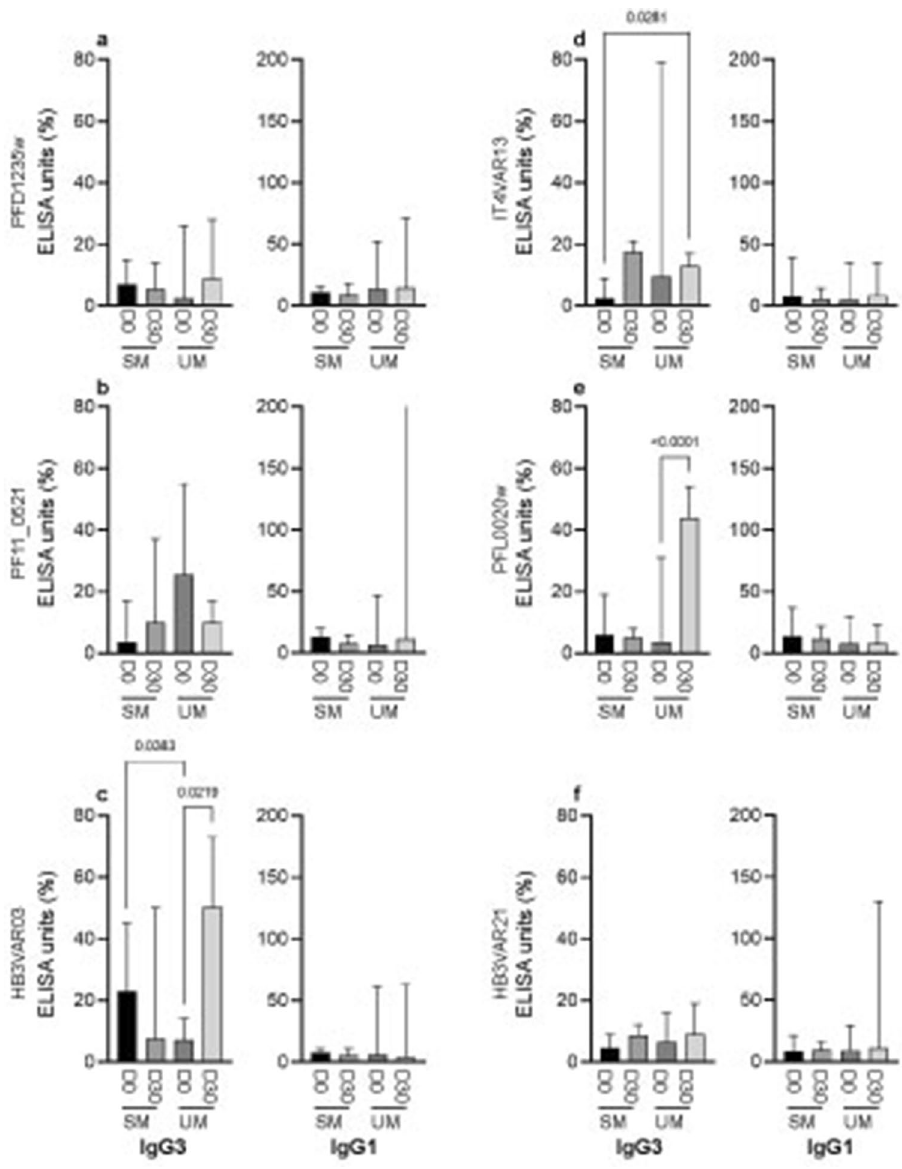
Figure 3. IgG subclass reactivity to group A and B ICAM-1-binding DBLβ domains. IgG1-4 antibody levels (ELISA units; EU) were measured in day 0 plasma samples from 84 of 137 Beninese children against DBLβ of according to clinical disease category, i.e., severe malaria (SM including CM and nCSM), and uncomplicated malaria (UM). The IgG2 and IgG4 median EU levels against any of the proteins were ≤ 9 EU (data not shown). Bars indicate the median and interquartile range. Statistical significance was determined using Wilcoxon matched pairs signed rank test and significant P -values shown along the top of the